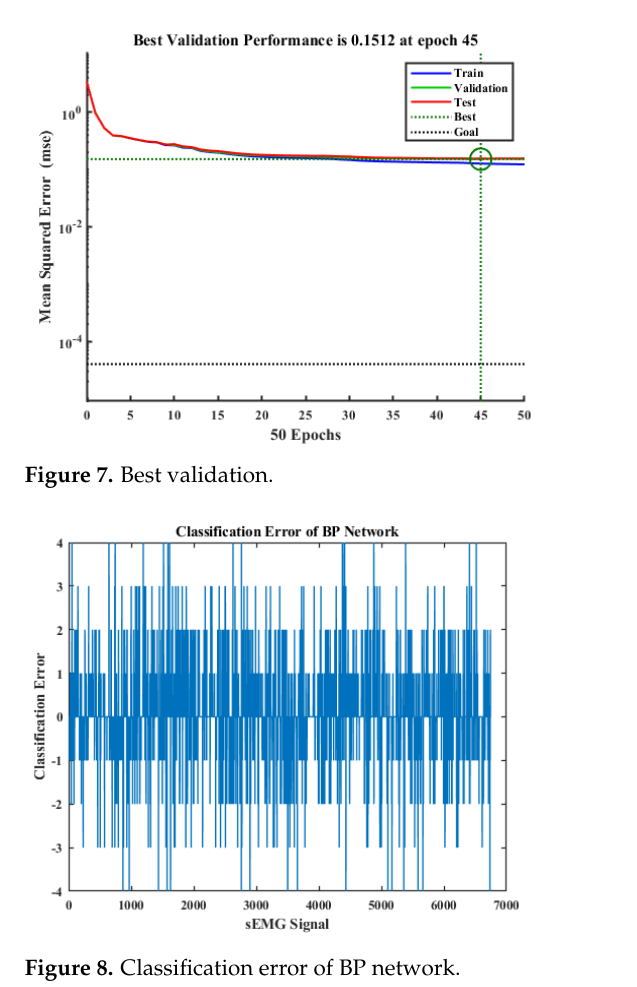
Figure 8. Classification error of BP network.